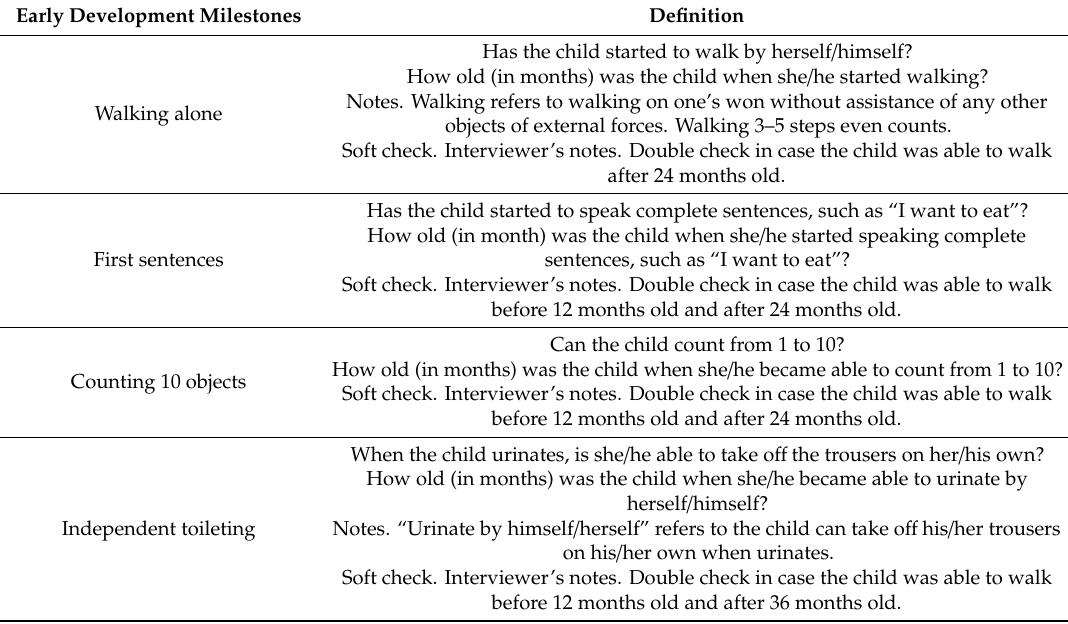
Table A2. Early Developmental Milestones.